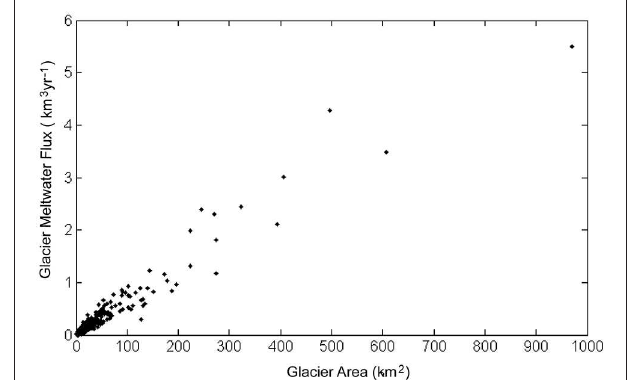
FIGURE 8 | Comparison of glacier area and meltwater flux for all glaciers using the APHRODITE climate data. Note the significant correlation between glacier area and flux. This is similar for all datasets, but with varying